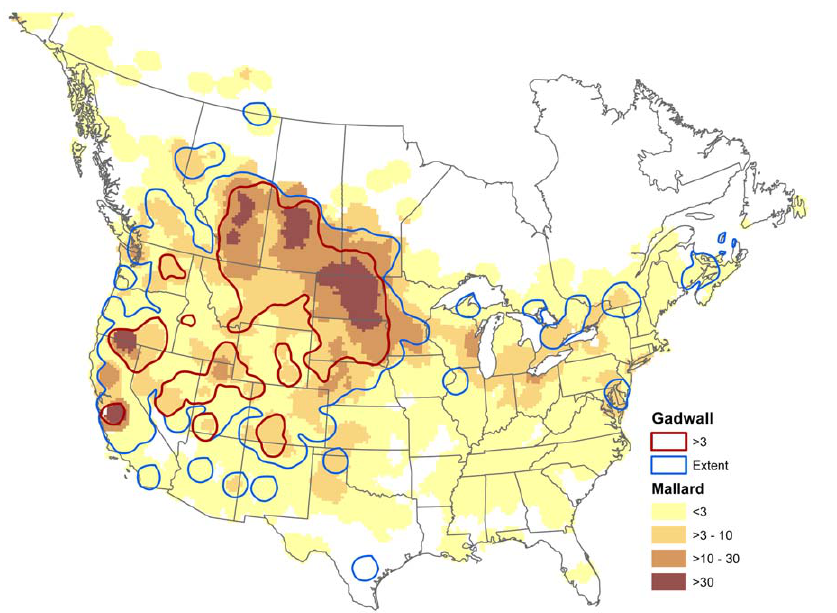
Figure 5. Map showing overlap in breeding relative abundance for mallard and gadwall species. Note that the geographic distribution of gadwall breeding locations is contained almost entirely by areas where mallard breed, with similar areas of high- and low-breeding concentrations across the contiguous United States. The mallard tested positive at some of the highest rates and the gadwall was near the lowest in proportion of AIV positive tests, suggesting geographic overlap alone does not explain variations in species prevalence